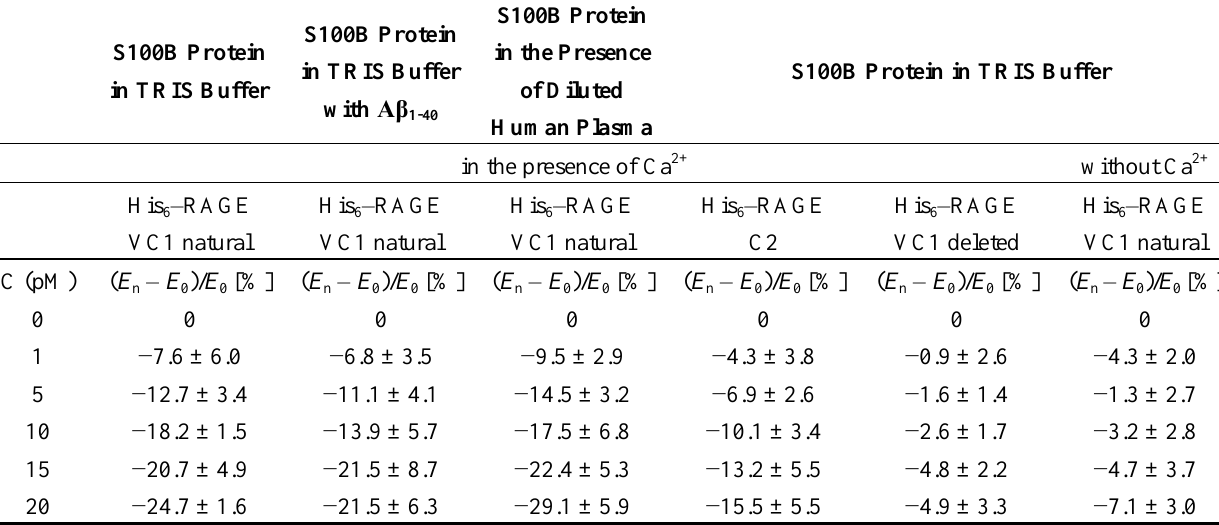
Table 2. The Cu(II) peak potential shift (%) measured with electrodes incorporating His –RAGE domains (VC1, VC1 deleted and C2) after incubation with S100B solution. 6 E is the peak potential measured in the presence of particular peptide concentration, E n the peak potential measured in buffer with no